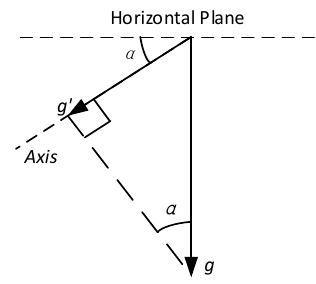
Figure 3. Measurement of Inclination from the Accelerometer. The accelerometer measures the value of (cid:1859)′ , which represents for the weight of the earth’s gravitational acceleration (cid:1859) in the axial direction on the sensor board. The tilt angle of the axis ∝ with respect to the horizontal plane can be calculated via an inverse trigonometric function: ∝= arcsin (cid:2917)' . (cid:2917)